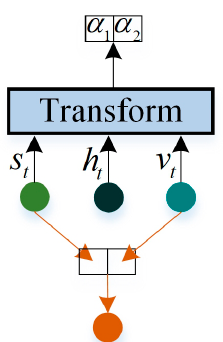
Figure 5. The architecture of attention3. This structure can learn a set of weights, which reflect the degree of attention to visual and semantic information. v t and s t are obtained by attention1 and degree of attention to visual and semantic information. t v and t s are obtained by attention1 and attention2, attention2, respectively.